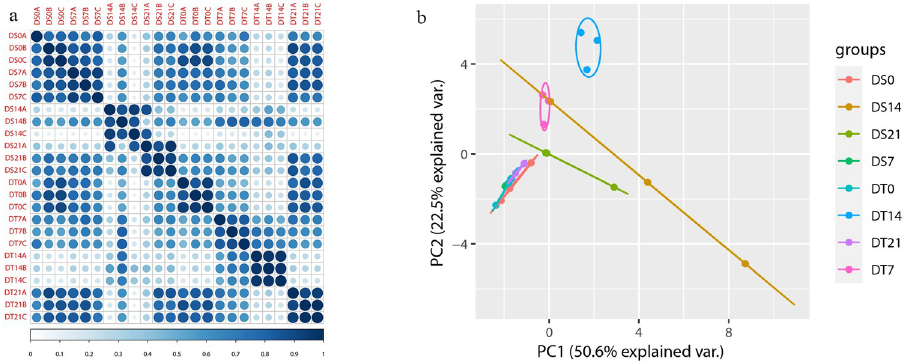
Fig 2. Transcriptional relationship among twenty-four samples. ( a) Person correlation coefficient analysis of transcriptome data from two sunflower varieties under drought stress. ( b) Principal component analysis of the data showing the variation due to genotype and